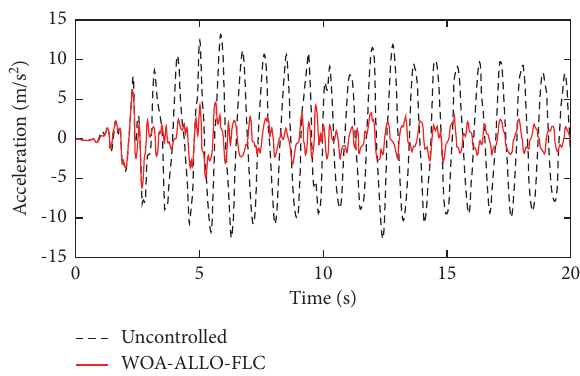
Figure 12: The top floor acceleration responses of Building 2. Table 9: Comparison of the performance criteria among different control methods.